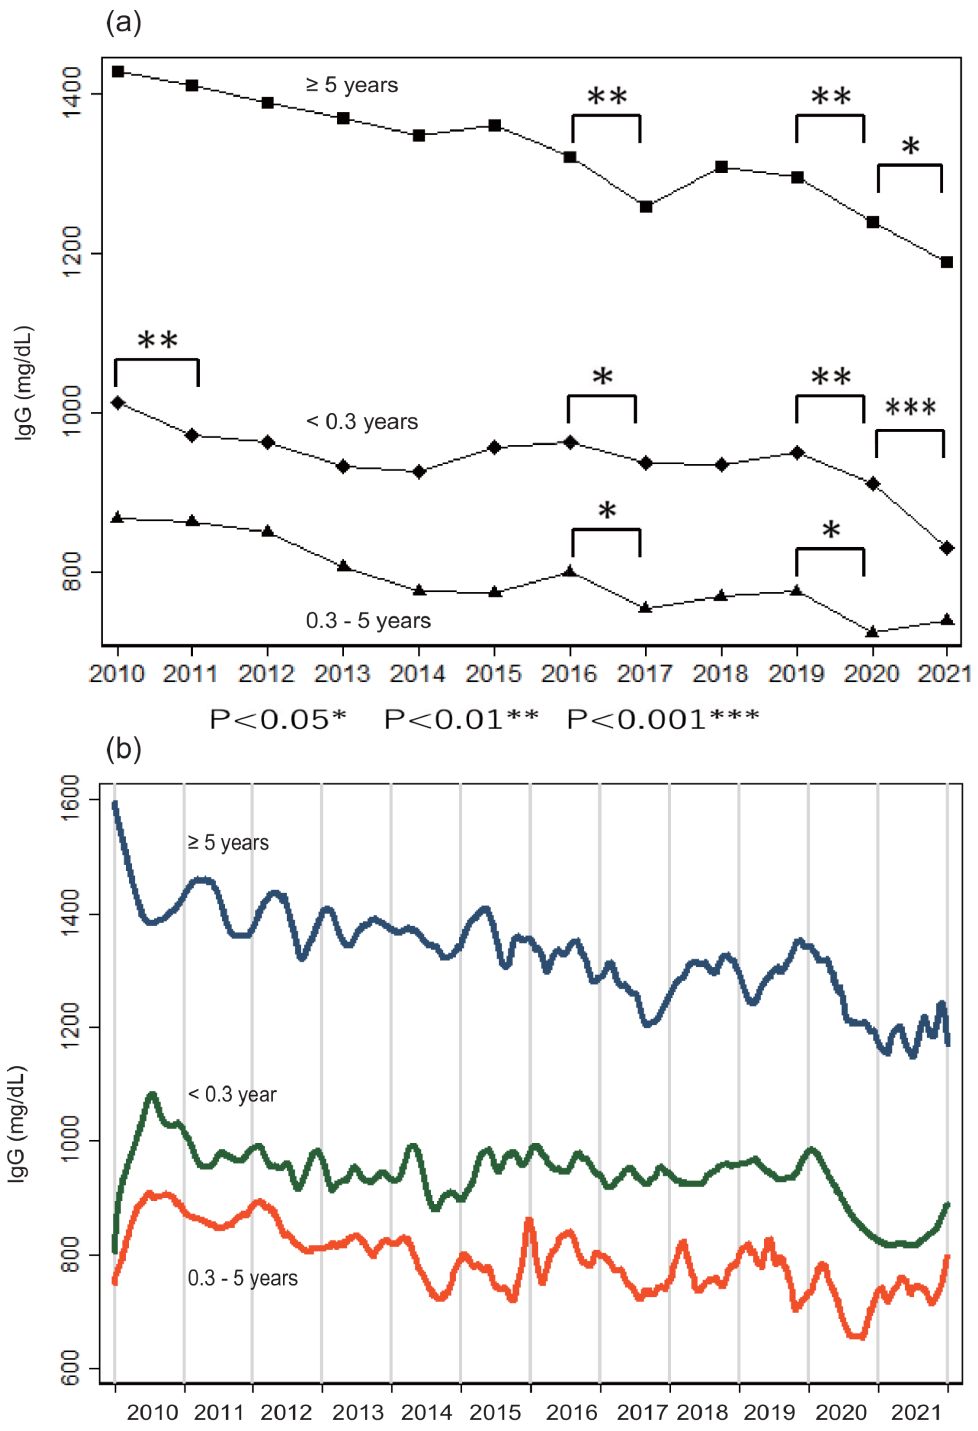
Fig 3. Temporal changes in IgG. (a) IgG values averaged for each year are presented for three age groups of individuals of < 0.3 years (diamond), 0.3–5 years (triangle) and � 5 years (square). Statistical comparisons between IgG values reported in one year and those reported in an adjacent year were performed using sum of rank tests (i.e., Mann-Whitney-Wilcoxon test). � P < 0.05, �� P < 0.01, ��� P < 0.001. (b) IgG values from these three age groups were smoothed using the Lowess method with a 14-day